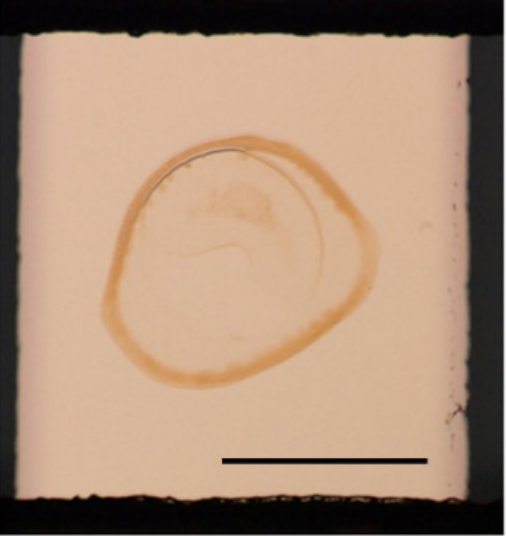
Figure 4. Photograph of electron mediator film applied on the electrode. Scale bar is 0.5 mm.